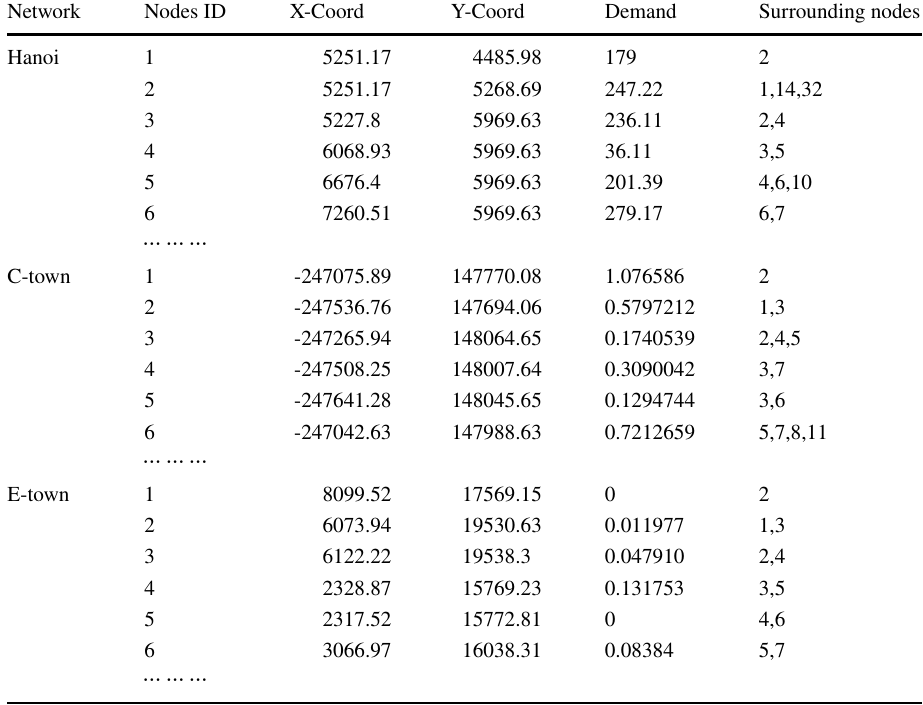
Table 1 Description of the data